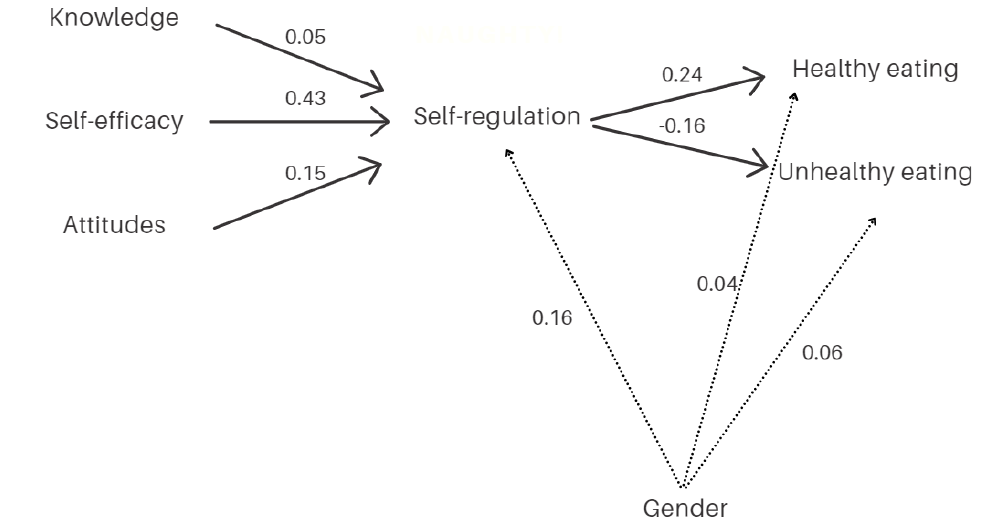
Figure 3. Principal results of the food consumption model.